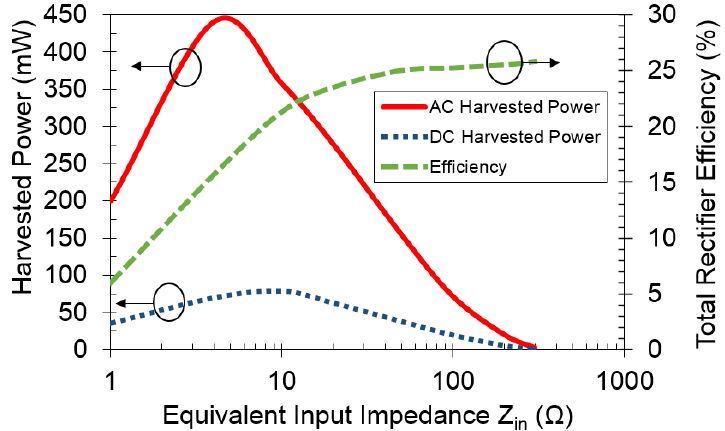
Figure 16. Measured harvested AC and DC power and total efficiency versus equivalent input impedance Z in .